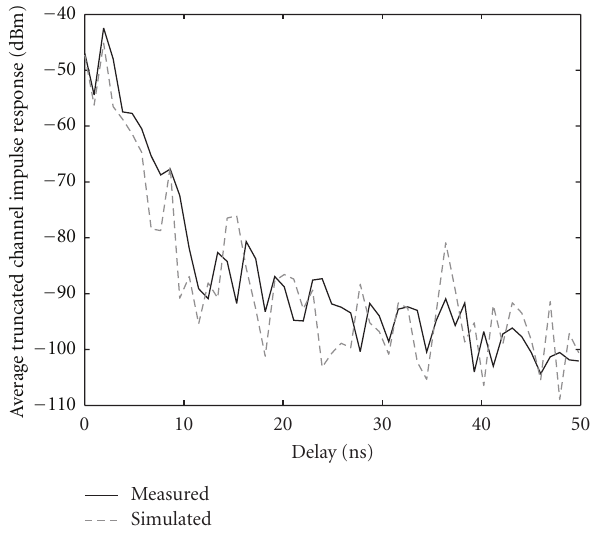
Figure 16: Average measured and simulated channel impulse responses for Rx17 (LOS) in the ISM band.